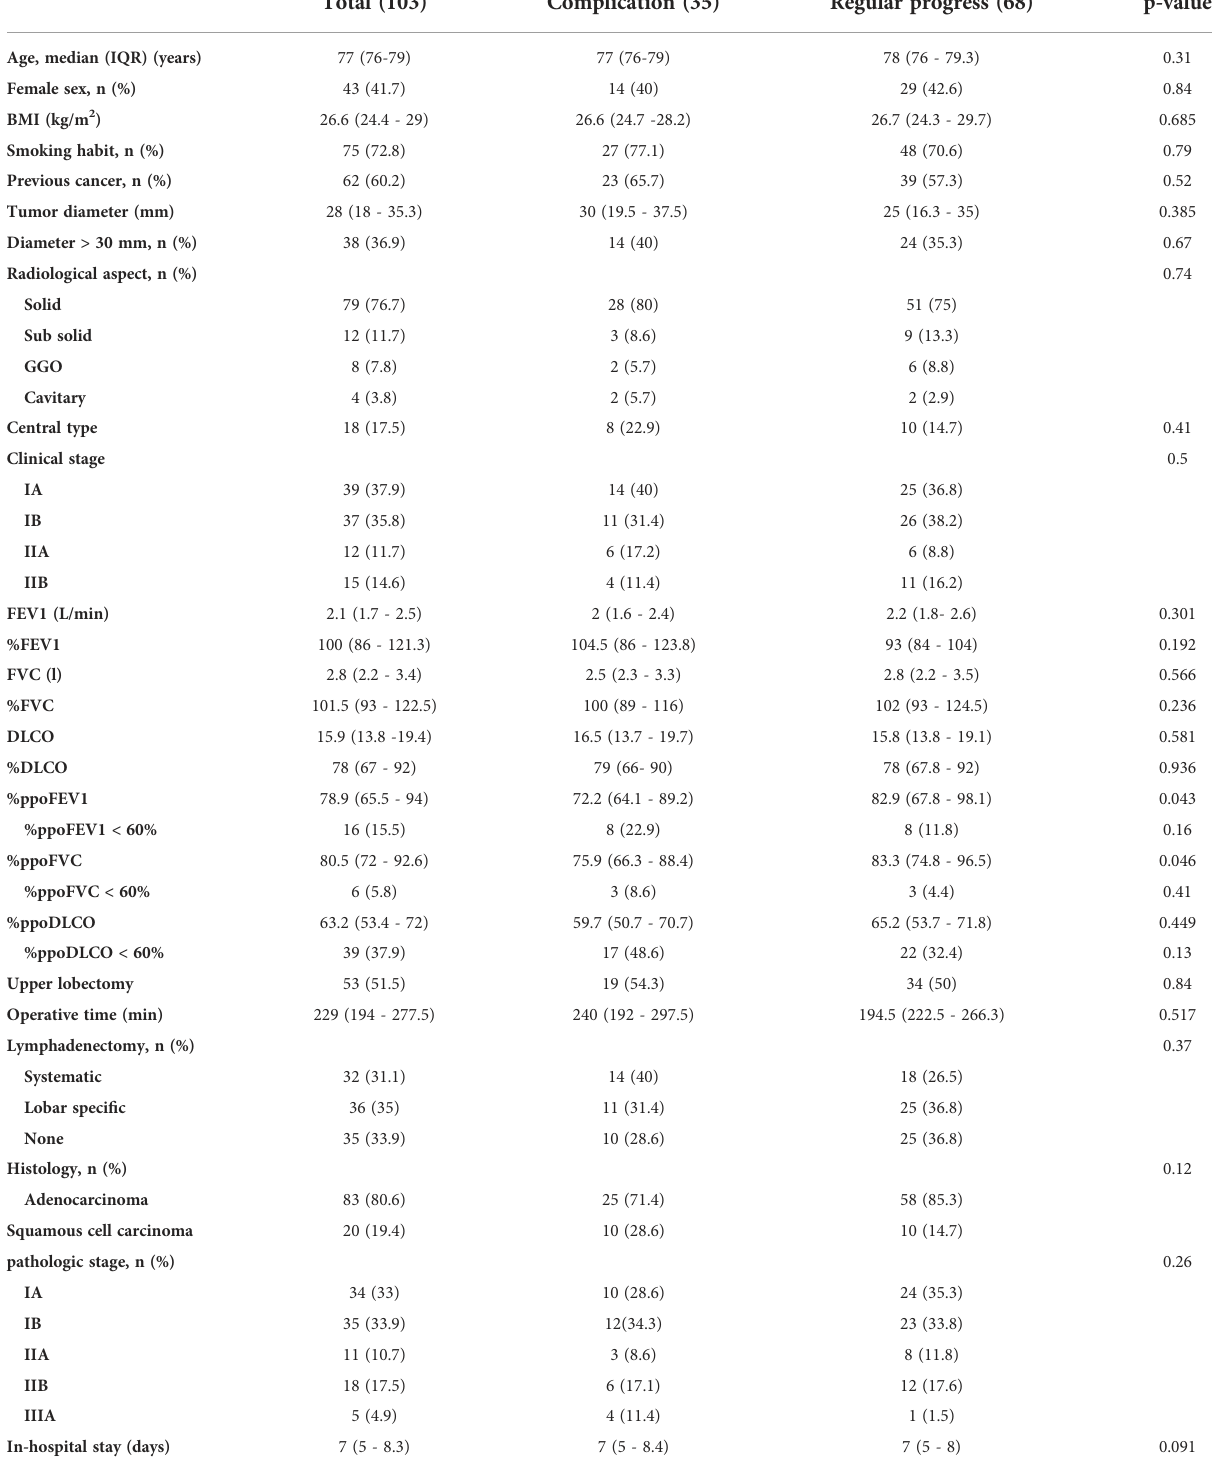
TABLE 1 Demographic and perioperative characteristics of the enrolled